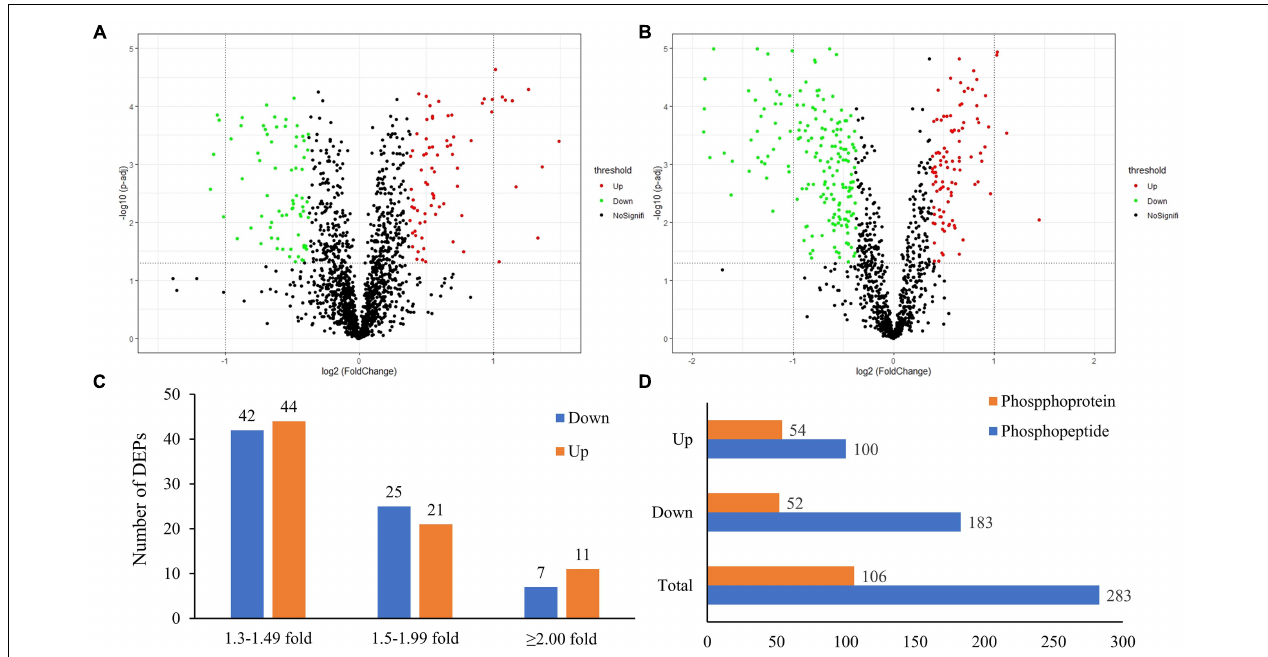
FIGURE 2 | The global proteome and phosphoproteome analysis of Yorkshire and Duroc boar spermatozoa. (A) Volcano plot of the quantified proteins in all biological replicates (the significant downregulated and upregulated protein shown in the green and red plots, respectively). (B) Volcano plot of the quantified phosphorylated sites in all biological replicates after TiO 2 enrichment (the significant downregulated and upregulated phosphorylated sites shown in the green and red plots, respectively). (C) The fold-change distribution of DEPs. (D) Summary of the DEPPs and DPPs between Yorkshire and Duroc boar